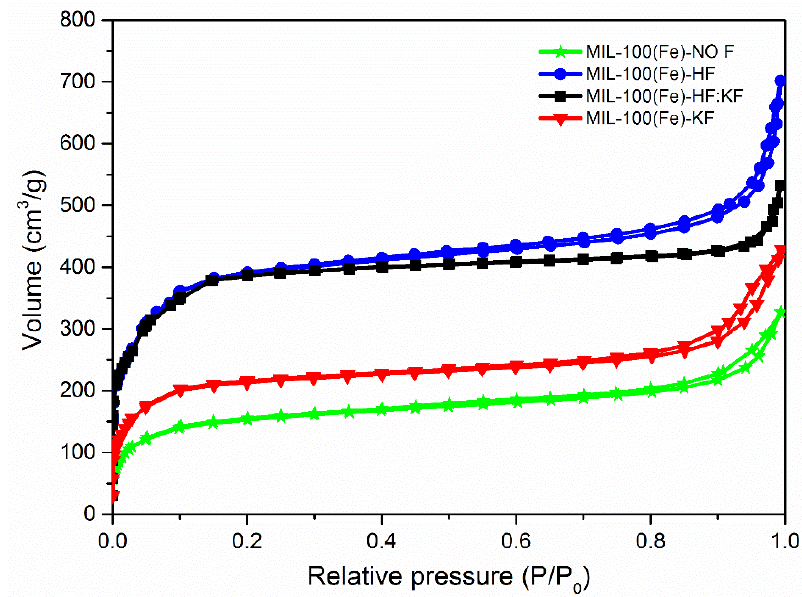
Figure 1. XRD pattern of the synthesized MIL-100(Fe) and simulated XRD pattern of MIL-100(Fe) (magenta) and α -Fe 2 O 3 .